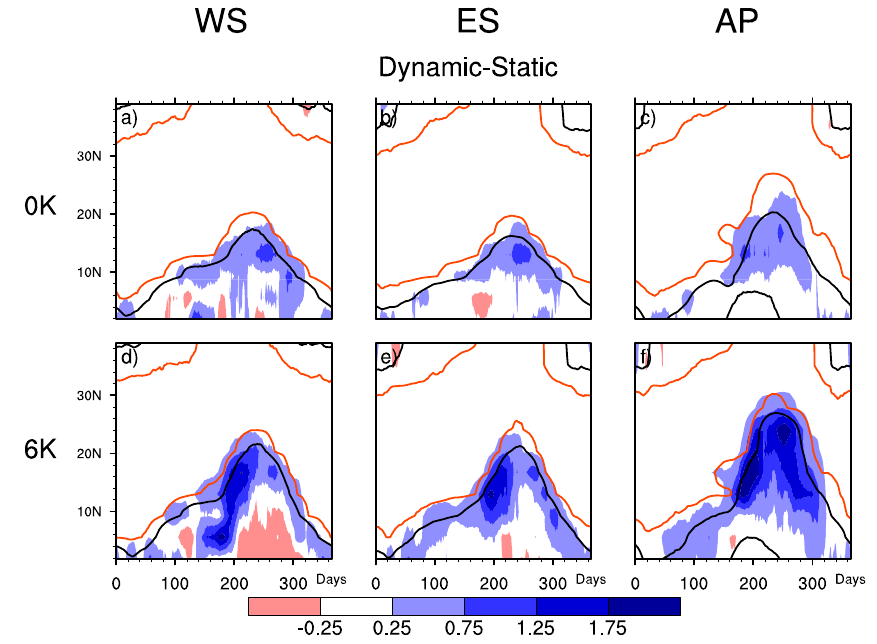
Fig. 6. Shown are differences in the annual cycle of precipitation in mmday − 1 derived from 100 simulation years (further filtered by 15-day running means) for the regions WS, ES and AP between 0K dyn and 0K st – (a) to (c) and between 6K dyn and 6K st – (d) to (f) . Overlayed are red and black contours representing the 0.25 and 1.25mmday − 1 isolines for 0K st – (a) to (c) and 6K st – (d) to (f)